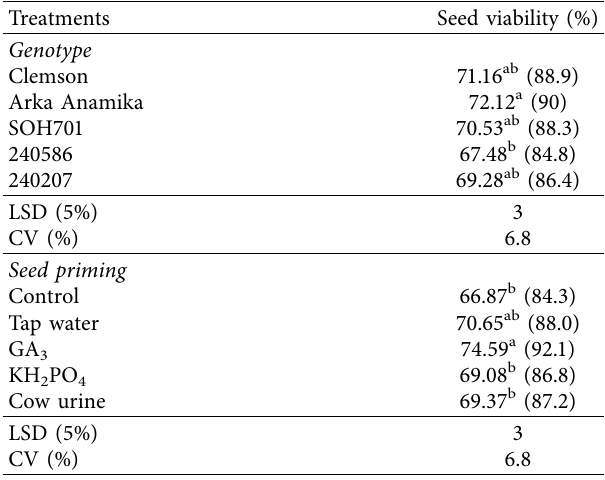
Table 4: Main efects of genotype and seed priming on okra seed